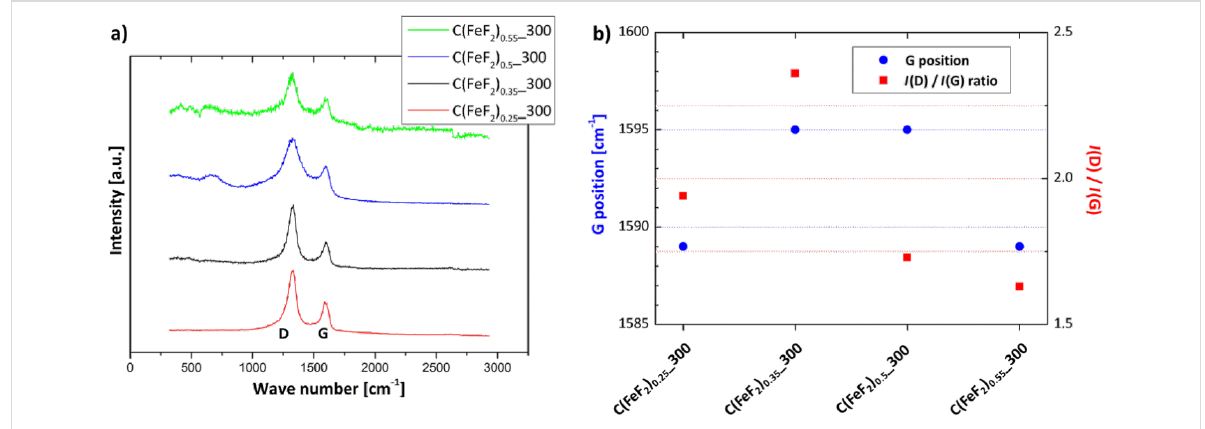
Figure 3: Measured Raman spectra and G-mode shifts of the different nanocomposites.